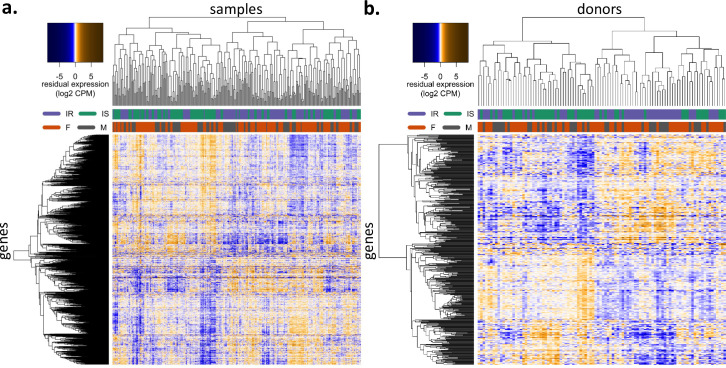
Differential expression analysis.(a) All-Samples (AS): 1338 differentially expressed genes with multiple testing corrected p-value<0.05 are shown. (b) Average-per-Patient (ApP): top 500 differentially expressed genes identified in ApP are shown. Color scale indicates normalized residual expression levels (blue: low expression, orange: high expression). Columns have been arranged according to clustering of the samples / donors, (purple: insulin resistant, turquoise: insulin sensitive, orange: female, grey: male). Clustering was performed on all samples / donors agnostically of their IR / IS status and sex.